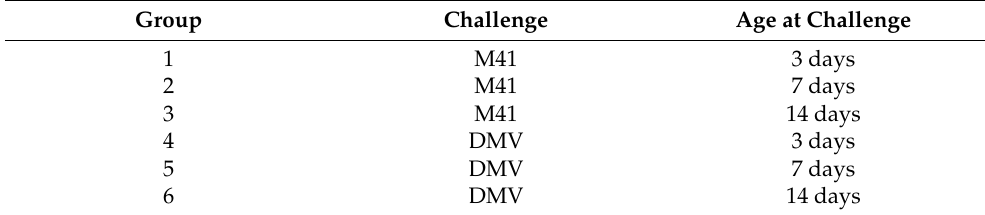
Table 1. Experimental Design and Summary of